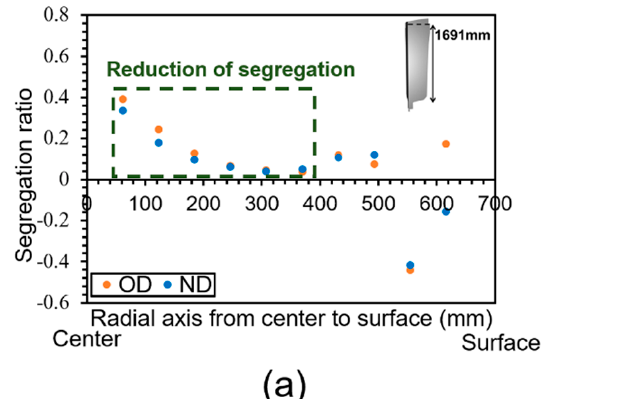
Figure 9. Static liquid pressure in OD and ND at point a, a height of 170 mm from the bottom and 378 mm in a radial direction from the center . There was thus more feeding in the lower regions of the ingot body to compensate for the contraction, and therefore, there was more fluid flow towards the ingot bottom. The formation of a columnar structure from the wall surface to the center during ingot solidification results in the rejection of solute elements from dendrite arms [6]. Therefore, increased fluid flow ahead of the solid front, resulting from a higher liquid pressure, sweeps up the rejected solute elements from the growing dendrites and transfers them to other locations in the molten metal pool. The results reported in Figure 10 show that the fluid velocity in ND was generally higher than in OD. The liquid fraction and liquid ve ‐ locity vectors at 33% solid formation are illustrated in Figure 10a. The magnitude of the fluid velocity was plotted in different locations and is indicated as line1 (L1), line2 (L2), line3 (L3), and line4 (L4) at the bottom, middle, top, and center of the ingot, respectively (Figure 10b–e, respectively). For example, an increase in fluid velocity in ND versus OD